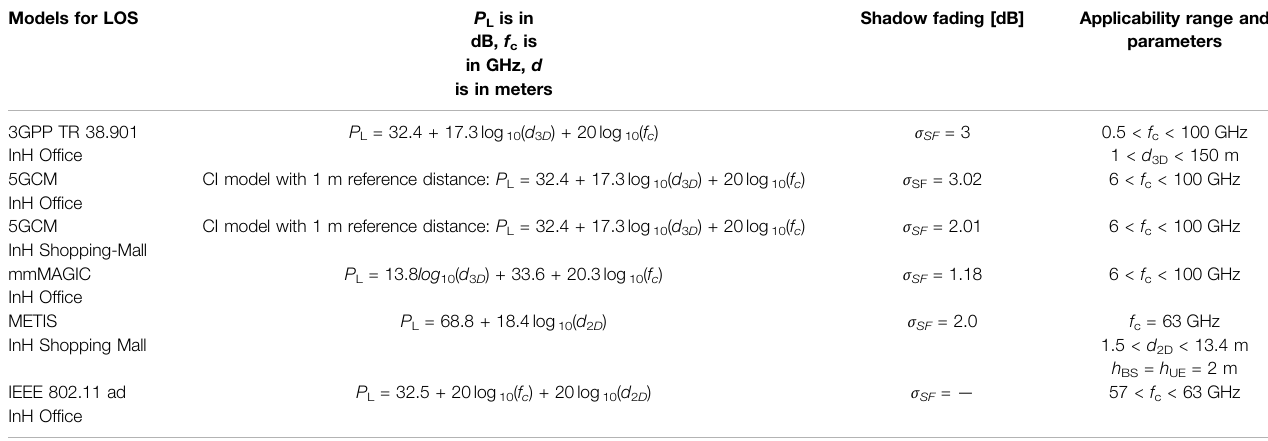
TABLE 2 | Channel models for LOS indoor of fi ce and shopping mall scenarios (Rappaport et al., 2017). Models for LOS P L is in